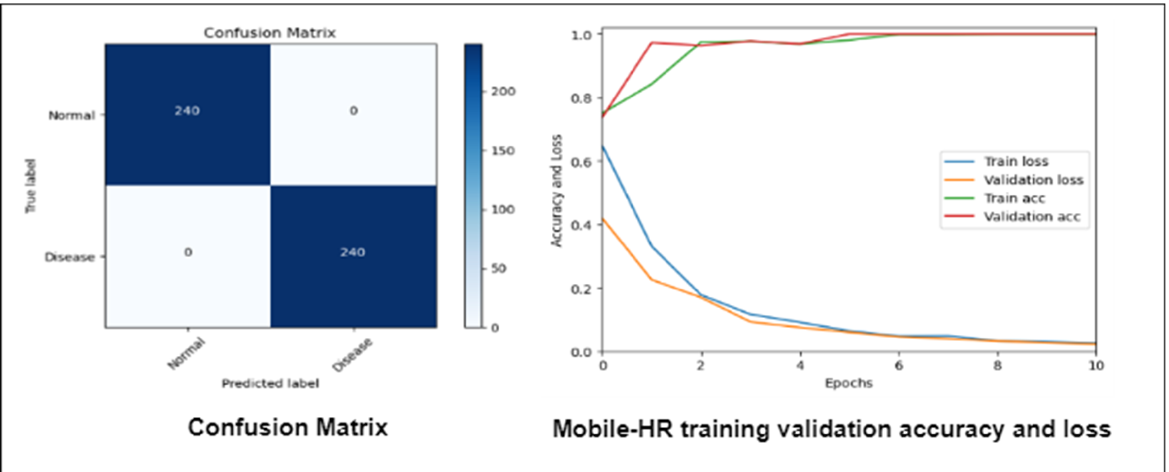
Figure 15. Mobile-HR model’s accuracy, loss, and confusion matrix using the Pak-HR Dataset.